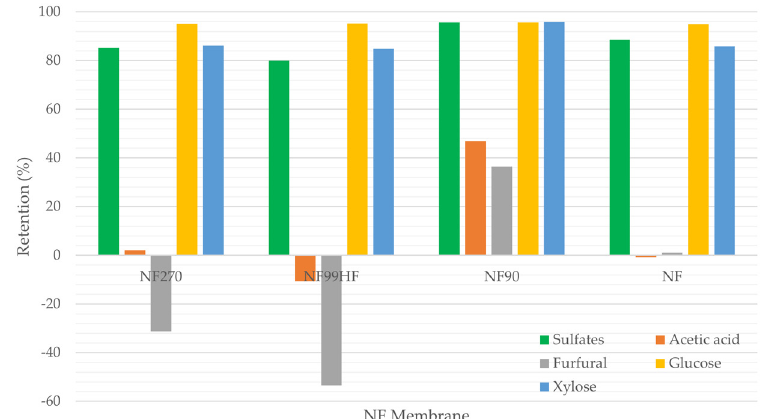
Figure 1. Retention of studied compounds by different nanofiltration (NF) membranes.